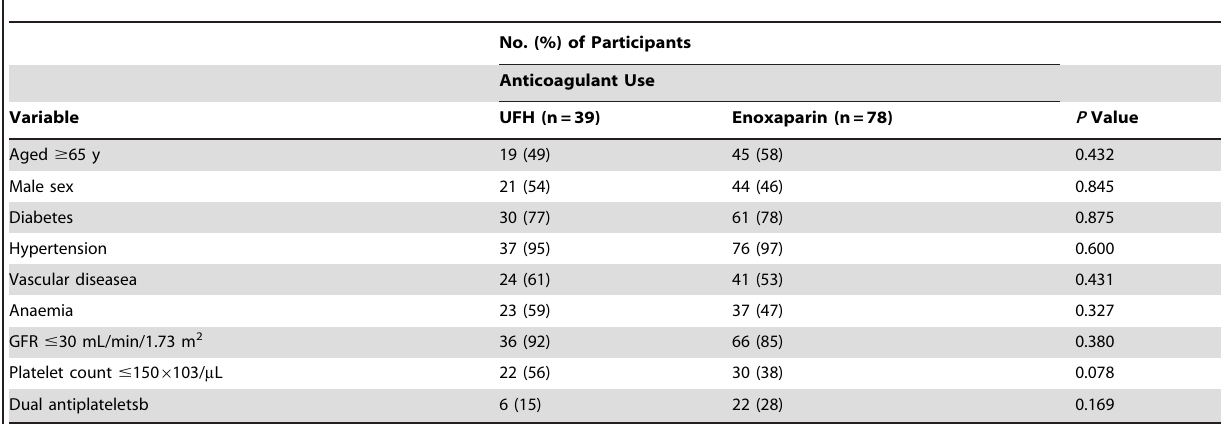
Table 6. Frequency of risk factors for major bleeding between unfractionated heparin and enoxaparin users.